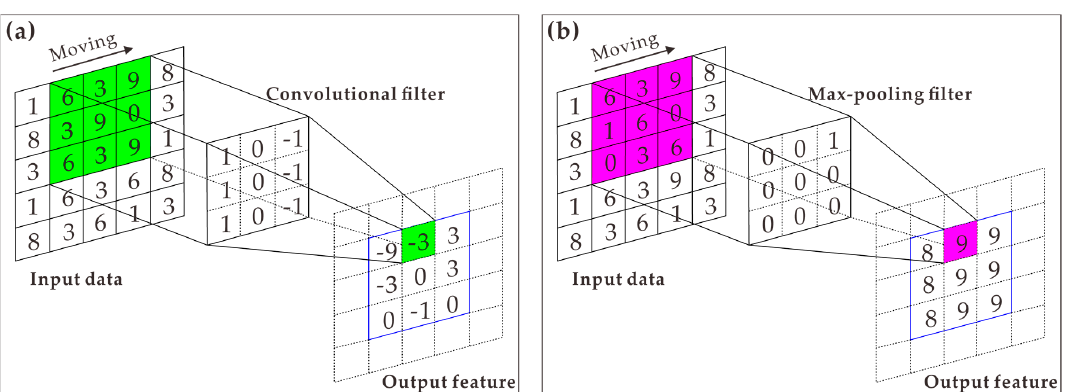
Figure 3. Examples illustrating the operations of convolution ( a ) and max pooling ( b ).